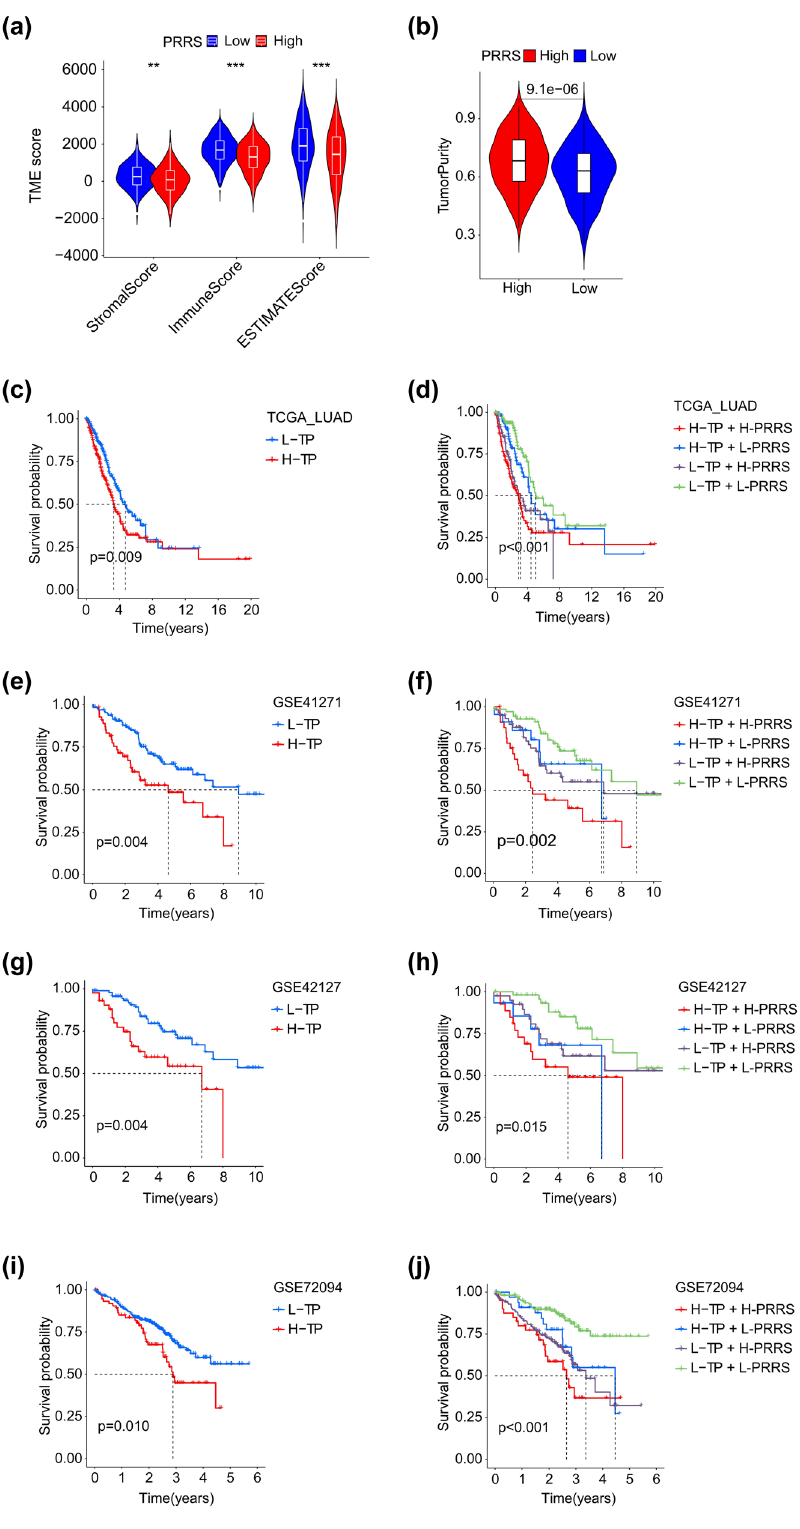
Figure 5: Tumor purity combined with PRRS to evaluate the prognosis of LUAD patients. ( a ) The immune, stromal, and ESTIMATE scores of the L - PRRS group were higher than the H - PRRS group ( p < 0.01 ) . ( b ) The tumor purity of the L - PRRS group was lower than the H - PRRS group ( p < 0.001 ) . ( c, e, g, i ) In the TCGA_LUAD ( c ) , GSE41271 ( e ) , GSE42127 ( g ) , and GSE72094 ( i ) cohorts, patients in the L - TP groups had a longer OS than the H - TP group ( p ≤ 0.01 ) . ( d, f, h, j ) In the TCGA_LUAD ( d ) , GSE41271 ( f ) , GSE42127 ( h ) , and GSE72094 ( j ) cohorts, patients in the L - TP + L - PRRS groups had the best prognosis, while the H - TP + H - PRRS had the worst prognosis. **, p < 0.01; ***, p < 0.001; L - TP: low tumor purity; H - TP: high tumor purity; L - PRRS: low PRRS; H - PRRS: high